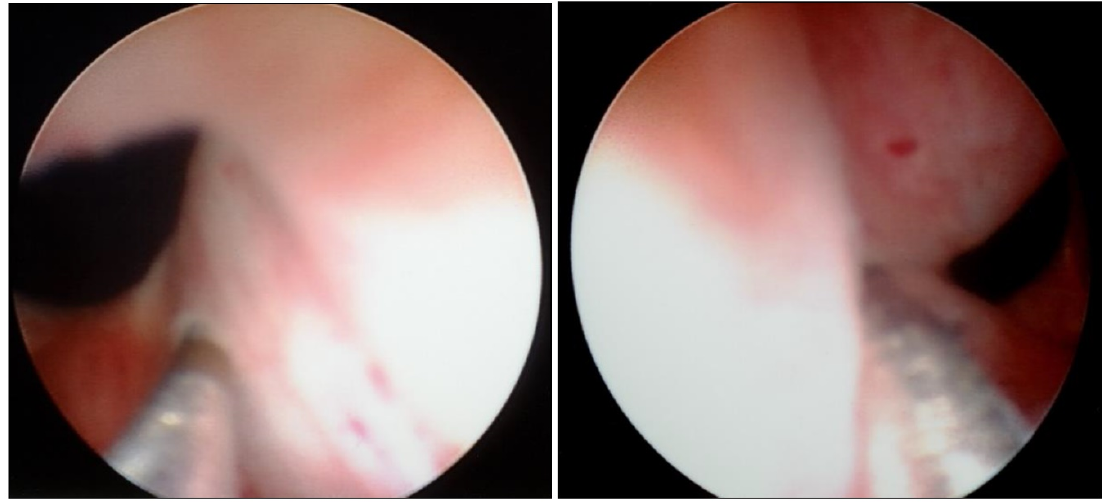
Figure 6. Transurethral retrograde bladder neck injection at 3 o’clock and 9 o’clock position.